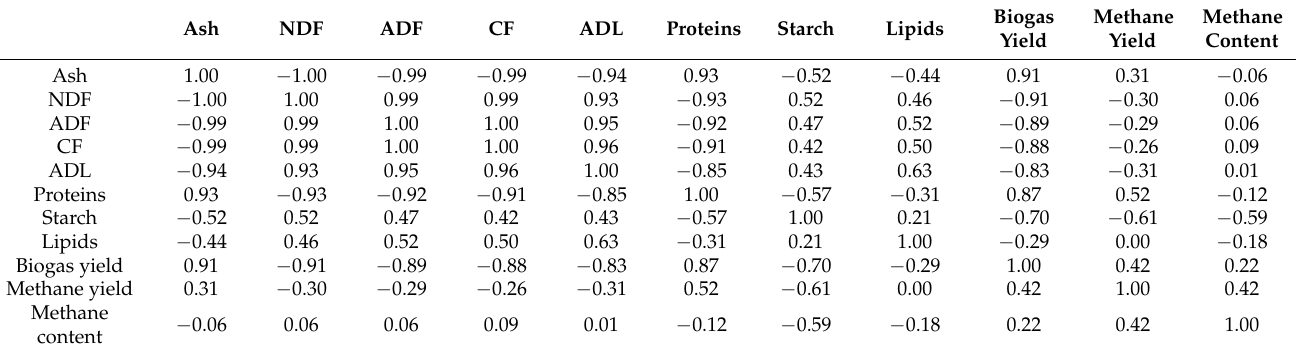
Legend to Table 10: Red color illustrates significant correlations ( p <